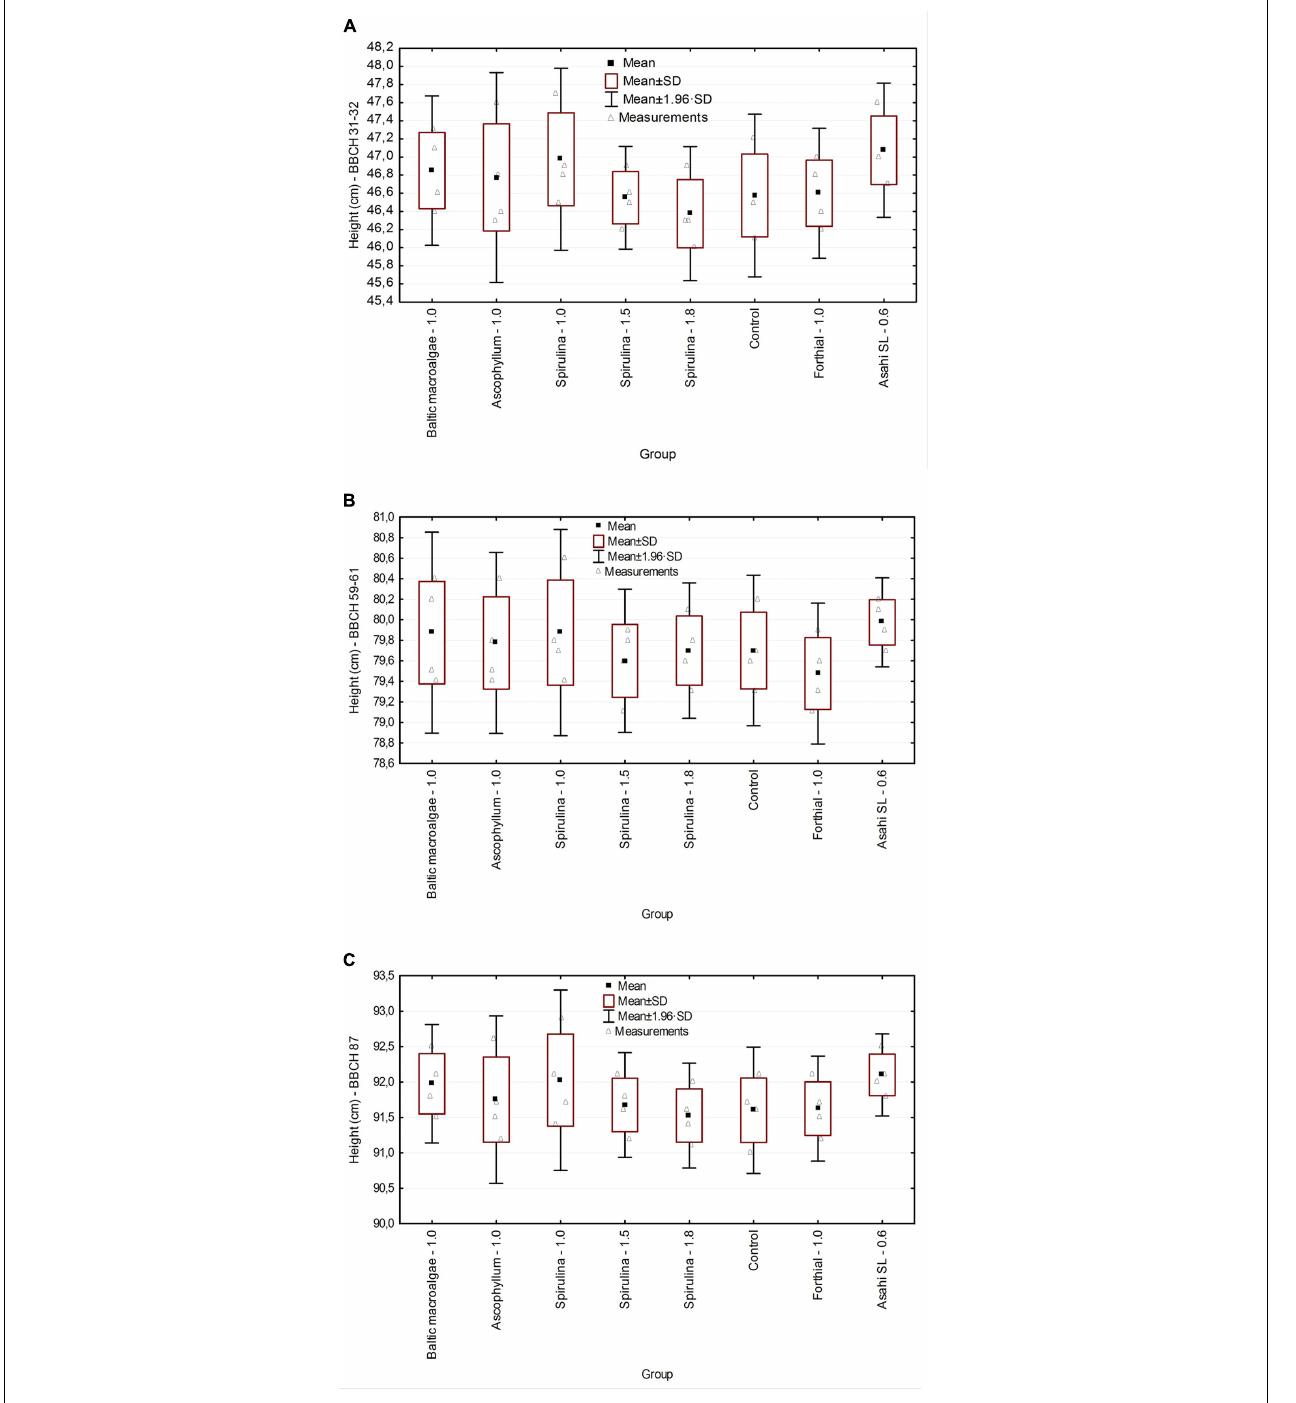
FIGURE 1 | Crop height (cm) at different BBCH crop growth stages: (A) 31–32, (B) 59–61, and (C) 87.